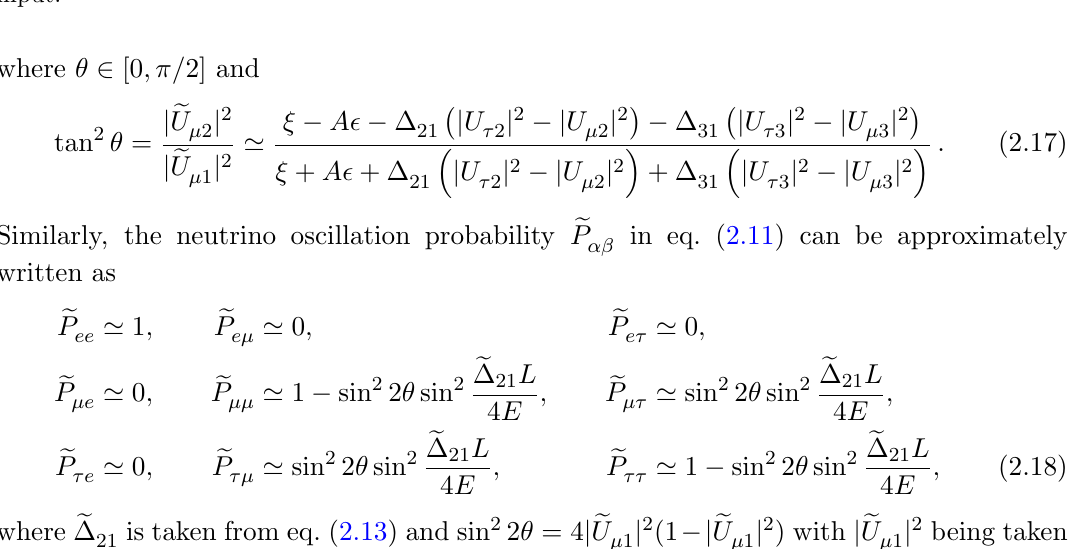
2 (for (cid:11) = e , U (cid:11)i j j e ; (cid:18) ; (cid:18) ; (cid:14); (cid:1) ; (cid:1) ) in refs. [36, 37] have been 12 13 23 21 31